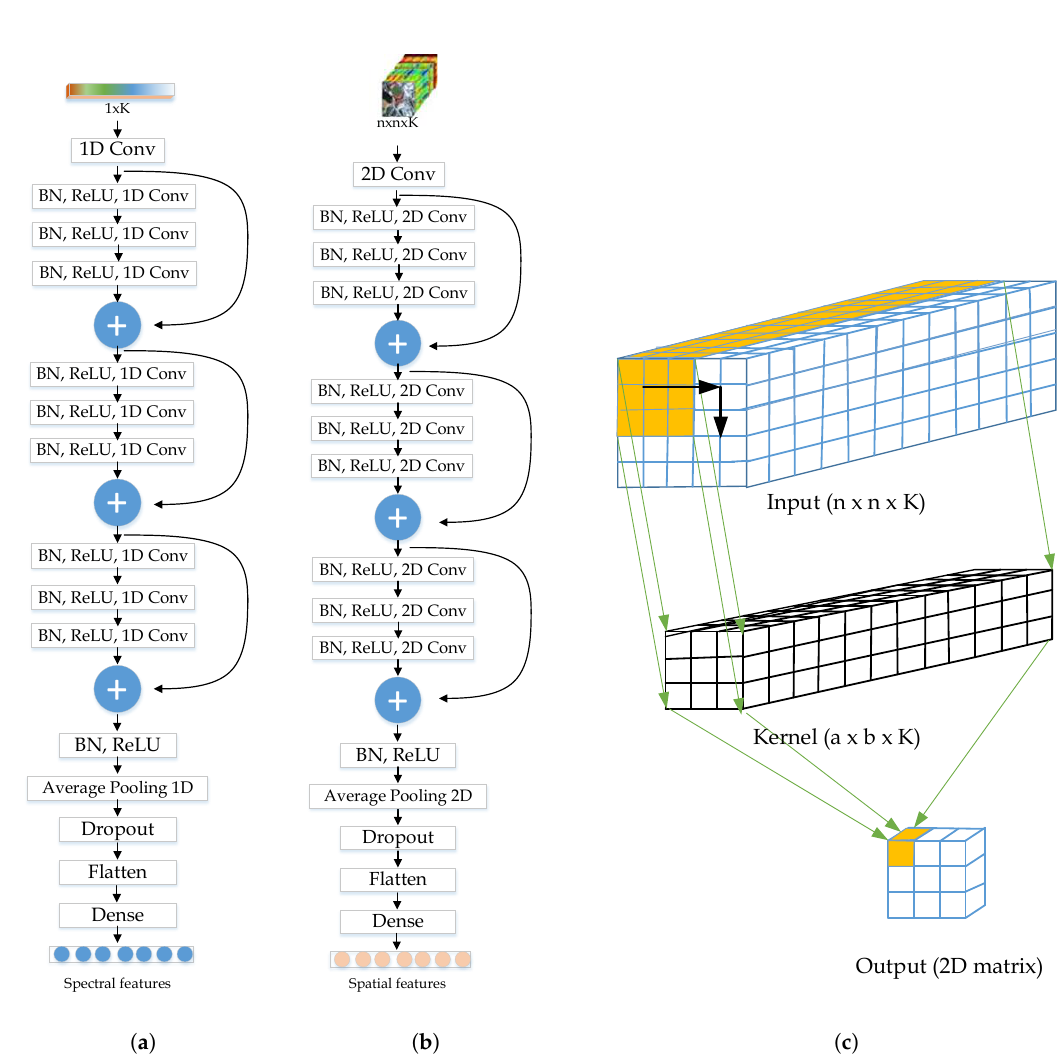
Figure 2. The detailed network of the ( a ) sRN, ( b ) saRN, and ( c ) the detail process of 2D convolution on 3D